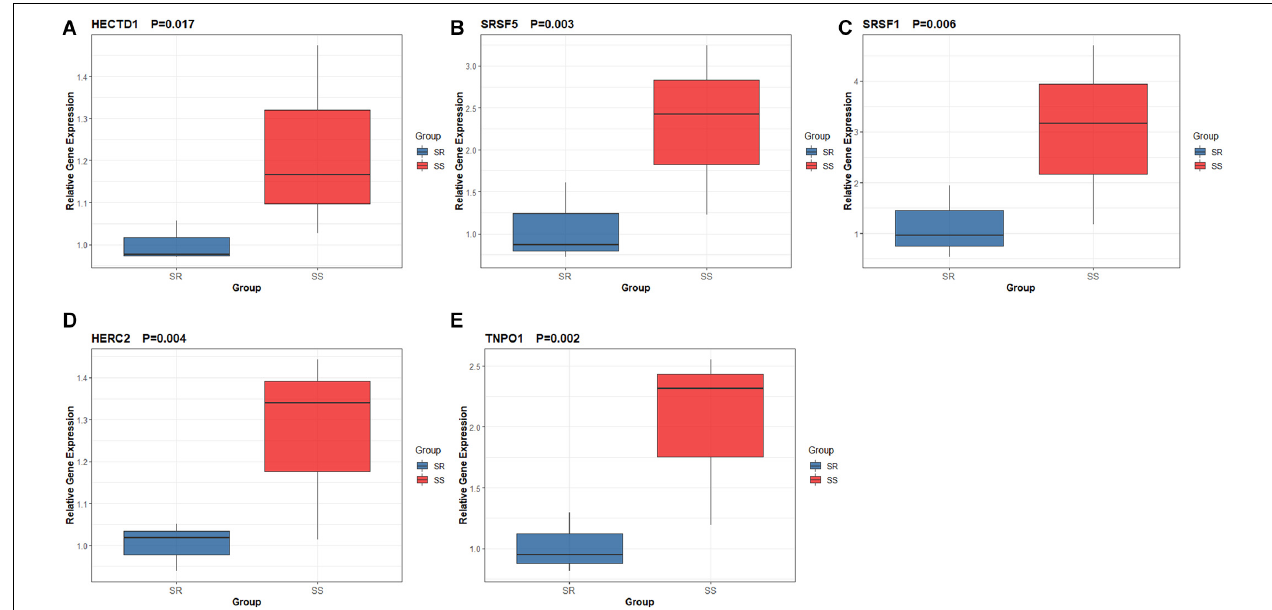
FIGURE 7 | Expression level of five hub genes by quantitative real-time PCR. (A) HECTD1. (B) SRSF5. (C) SRSF1. (D) HERC2. (E)